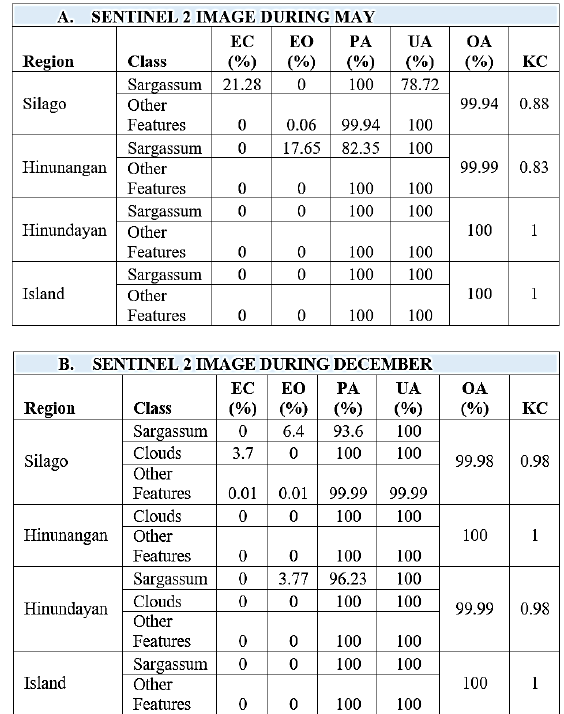
Table 1. Classification accuracy of: (A) May Sentinel-2 image